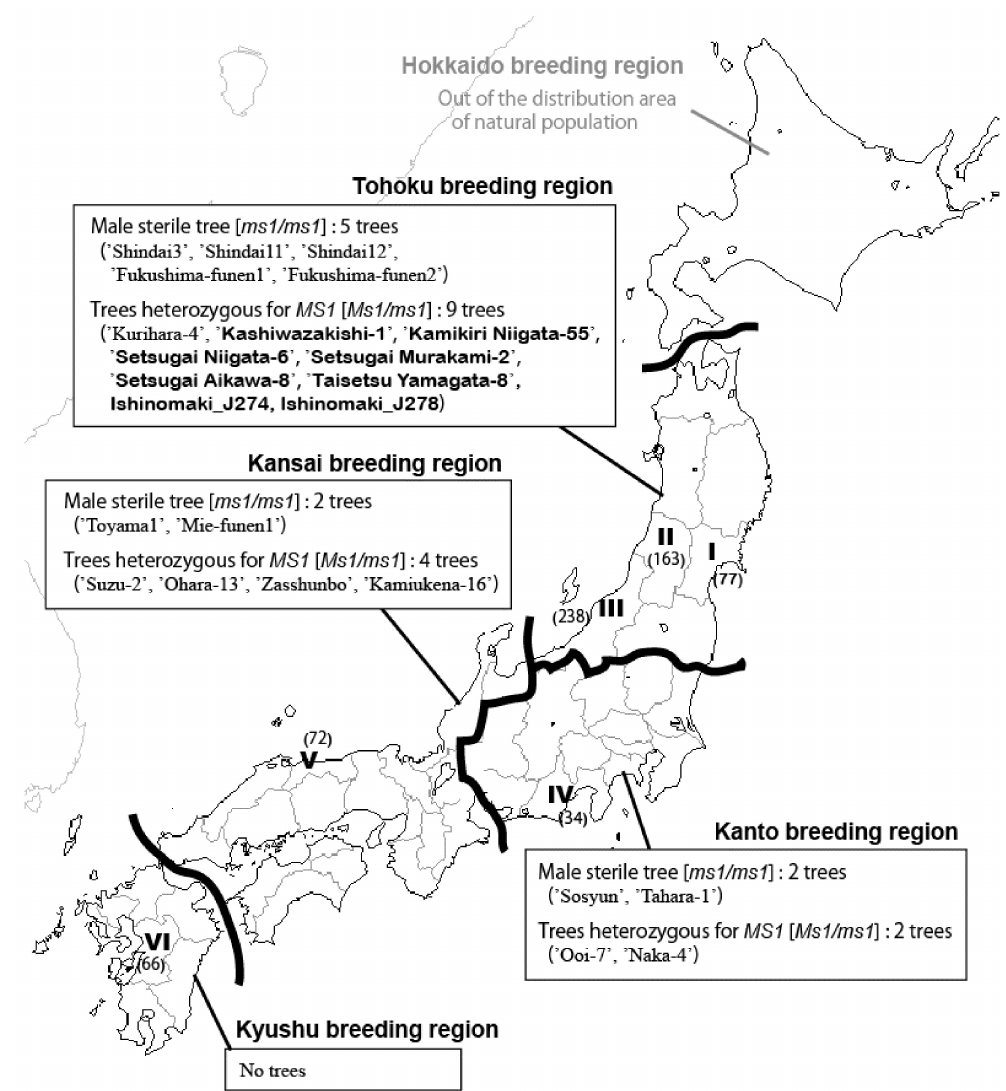
Figure 2. Breeding materials with MALE STERILITY 1 in four C. japonica breeding regions. The bold font shows the selected trees in this study. Roman numerals indicate the prefectures where marker-assisted selection (MAS) was performed (I: Miyagi, II: Yamagata, III: Niigata, IV: Shizuoka, V: Tottori, VI: Kumamoto). Numbers in parentheses indicate the sample